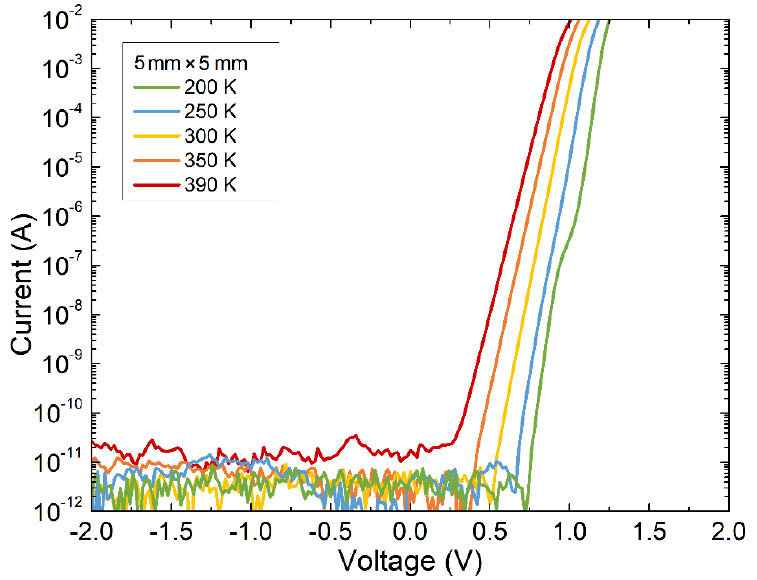
Figure 3. Temperature-dependent current voltage (I-V) measurement of 4H-SiC detector with active surface area of 5 mm × 5 mm. Measurements were performed in a vacuum in the temperature range from 200 K to 390 K.